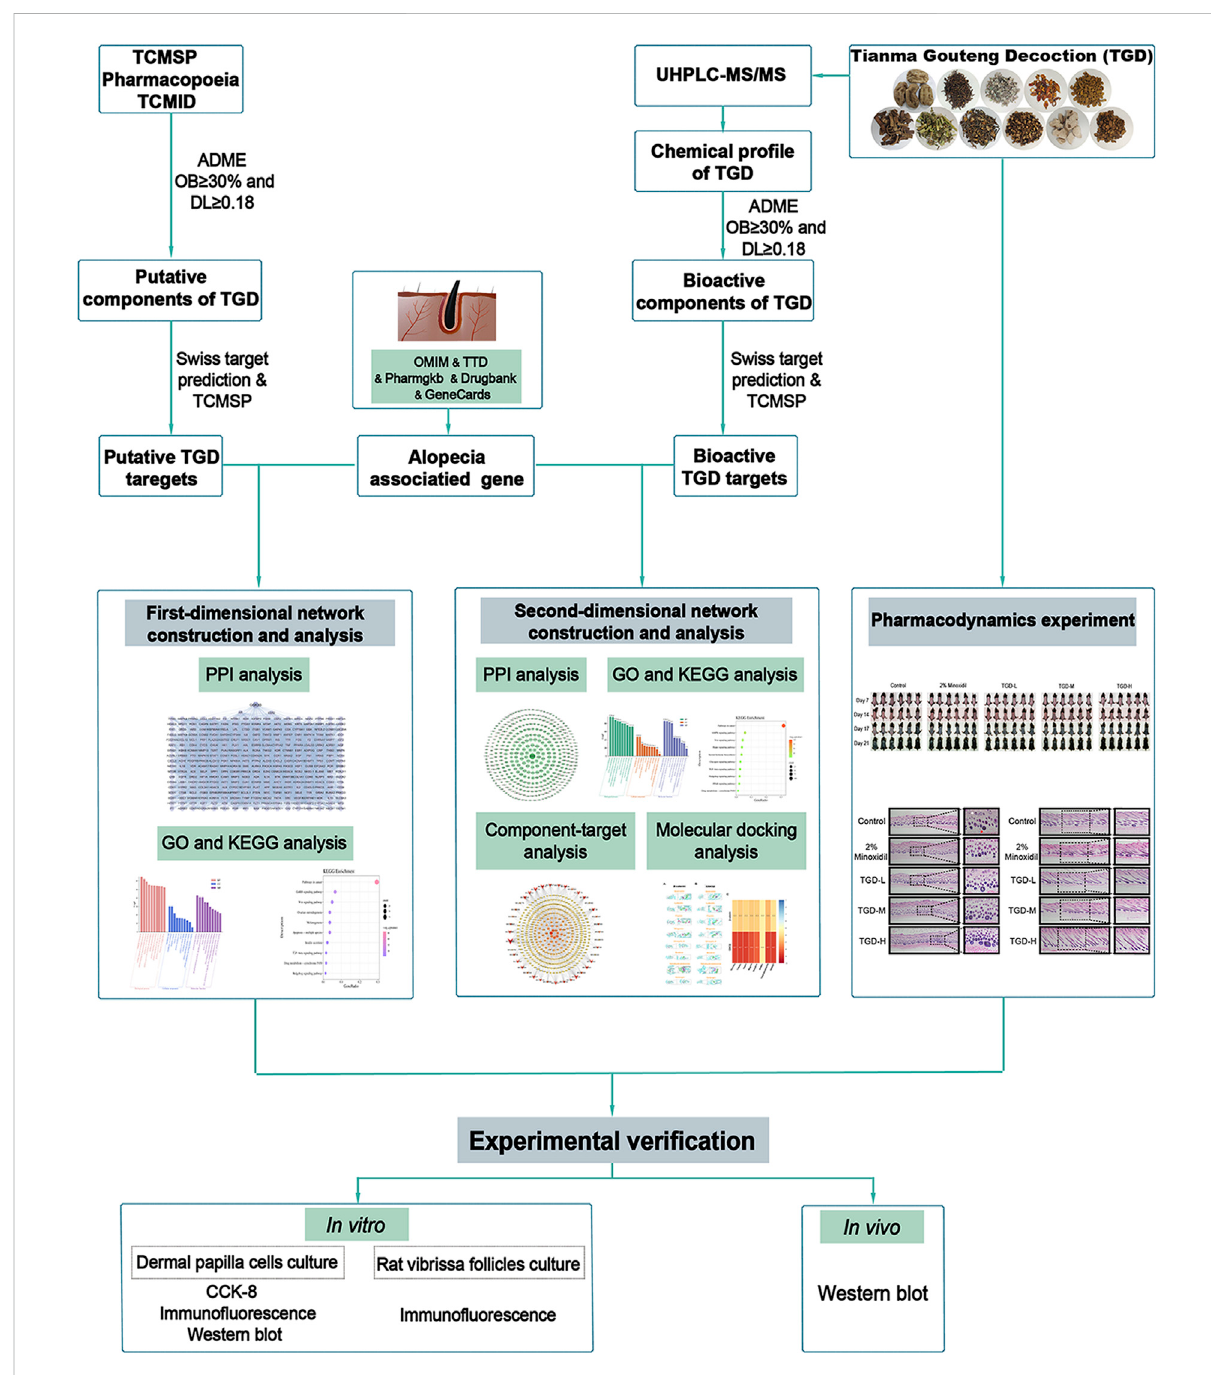
FIGURE 1 The technical strategy of the current